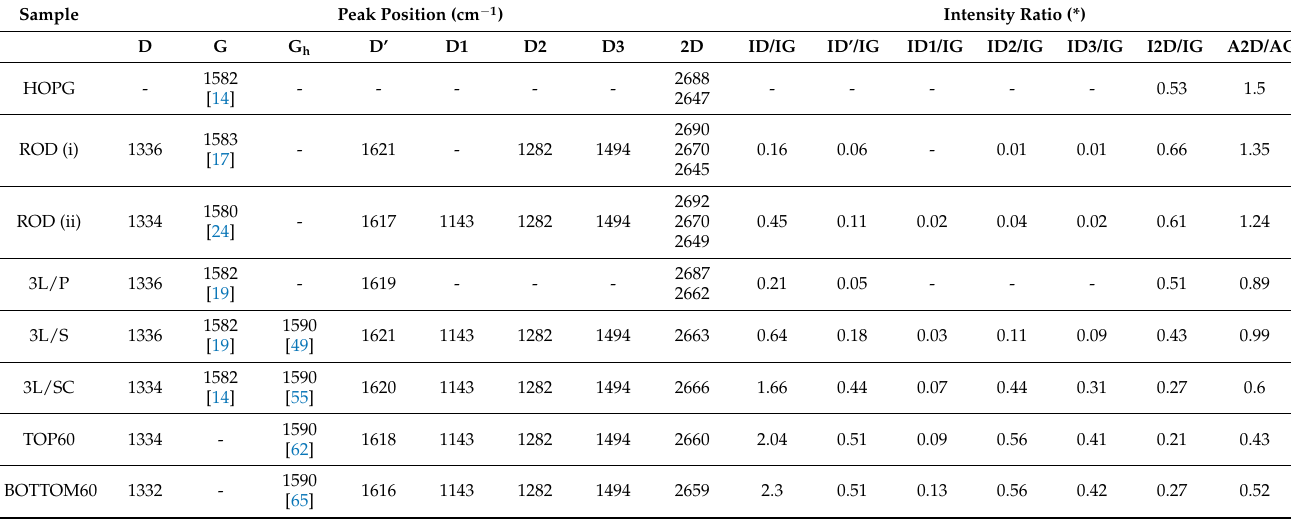
Table 4. Parameters obtained after deconvolution of the Raman spectra ( λ exc = 633 nm) of the samples listed in the first column. Full Width at Half Maximum (FWHM) of the G or G h line are listed in squared brackets after peaks wavenumbers (columns II and